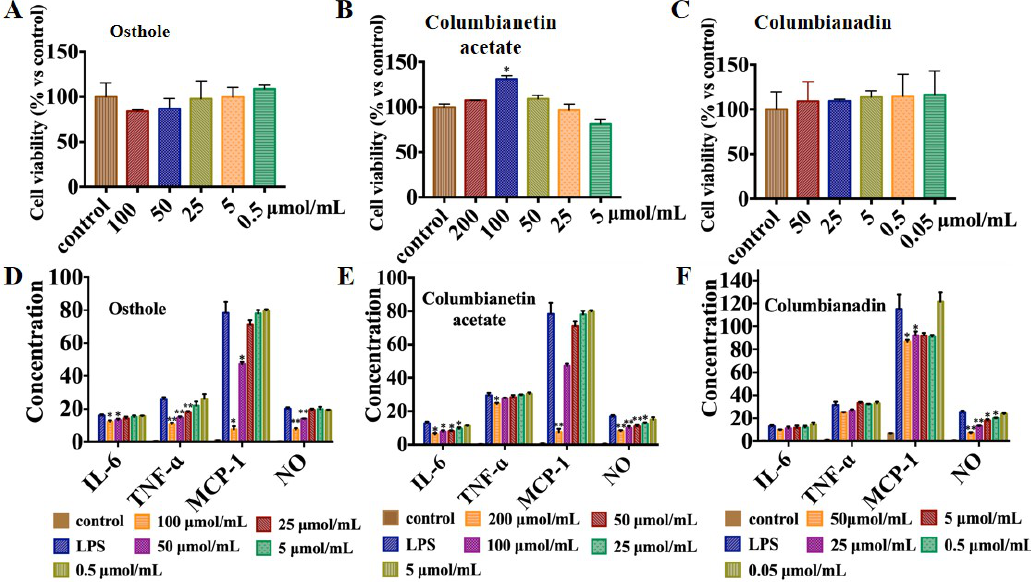
Figure 7. The cell viability of three coumarins ( A , B , C ); The anti-inflammatory effects of three coumarins on IL-6 (ng/mL), TNF-α (ng/mL), MCP-1 (ng/mL) and NO (μM) levels in Lipopolysaccharide (LPS)-stimulated RAW264.7 macrophages ( D , E , F ). Data are presented as mean (LPS)-stimulated RAW264.7 macrophages ( D – F ). Data are presented as mean ± SD of three independent ± SD of three independent experiments performed in duplicate. * p < 0.05 and ** p < 0.01 versus LPS experiments performed in duplicate. * p < 0.05 and ** p < 0.01 versus LPS group.